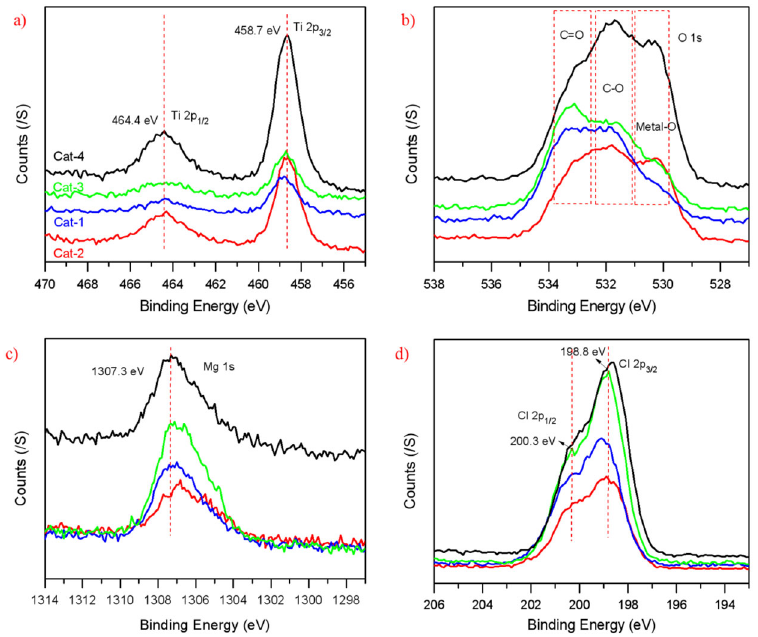
Figure 3. ( a – d ) XPS characterization results from the POP-based and MgCl 2 -based Z–N catalysts. The multiple peaks of O 1s could be attributed to C=O, C-O and Ti-O/Mg-O bonds formed from the HEMA units in the POP and the added IDs, approximately around 533.8–532.5 ev, 532.5–531.0 ev and 531.0–529.5 ev, respectively. With the same